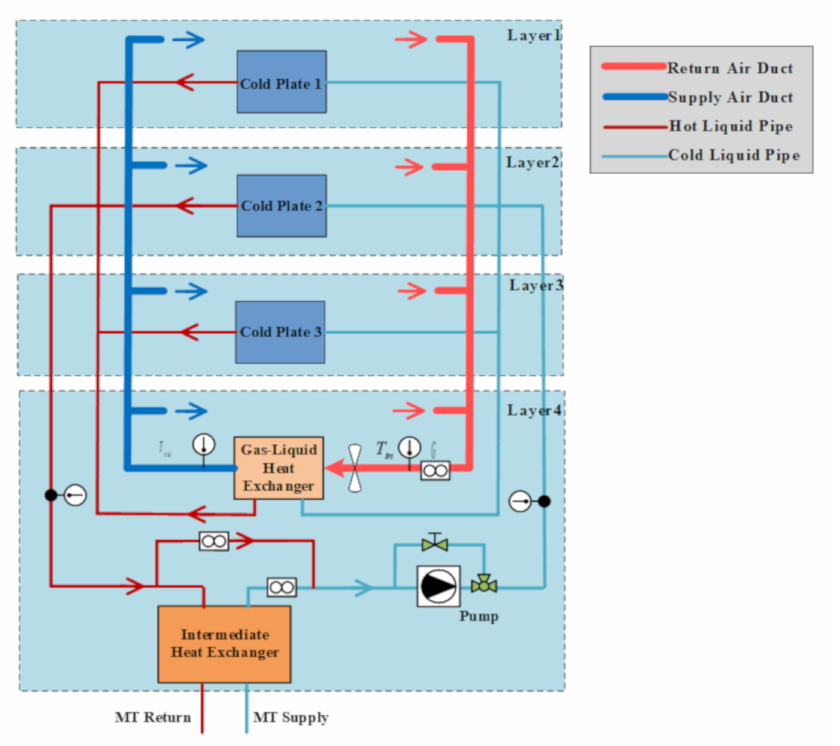
Figure 2. Schematic diagram of rack cooling system.